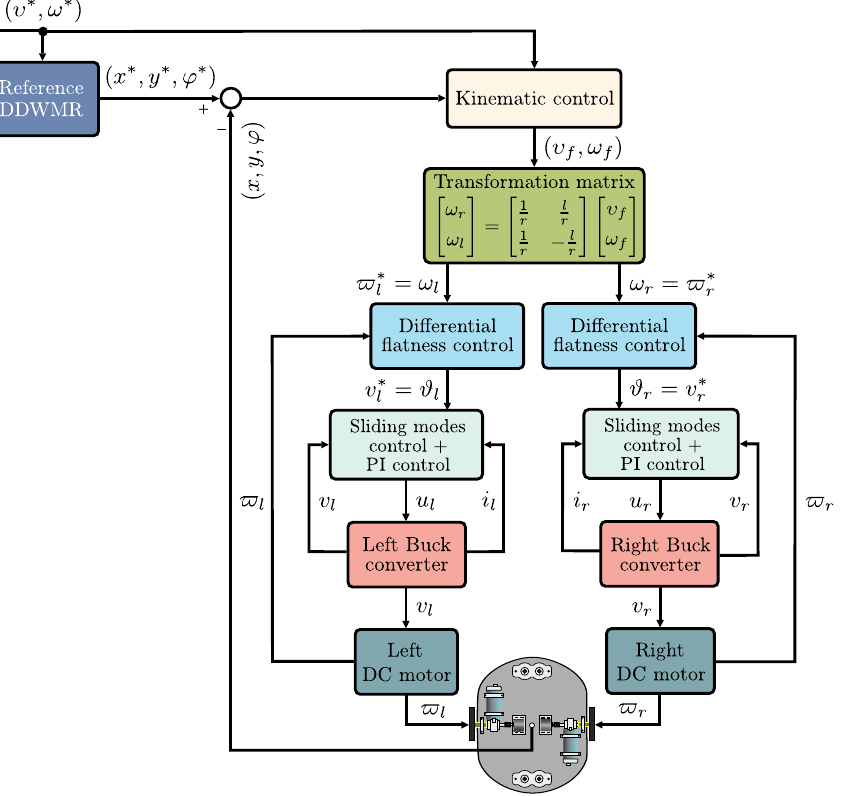
Figure 2. Block diagram of the hierarchical switched controller in closed-loop with the